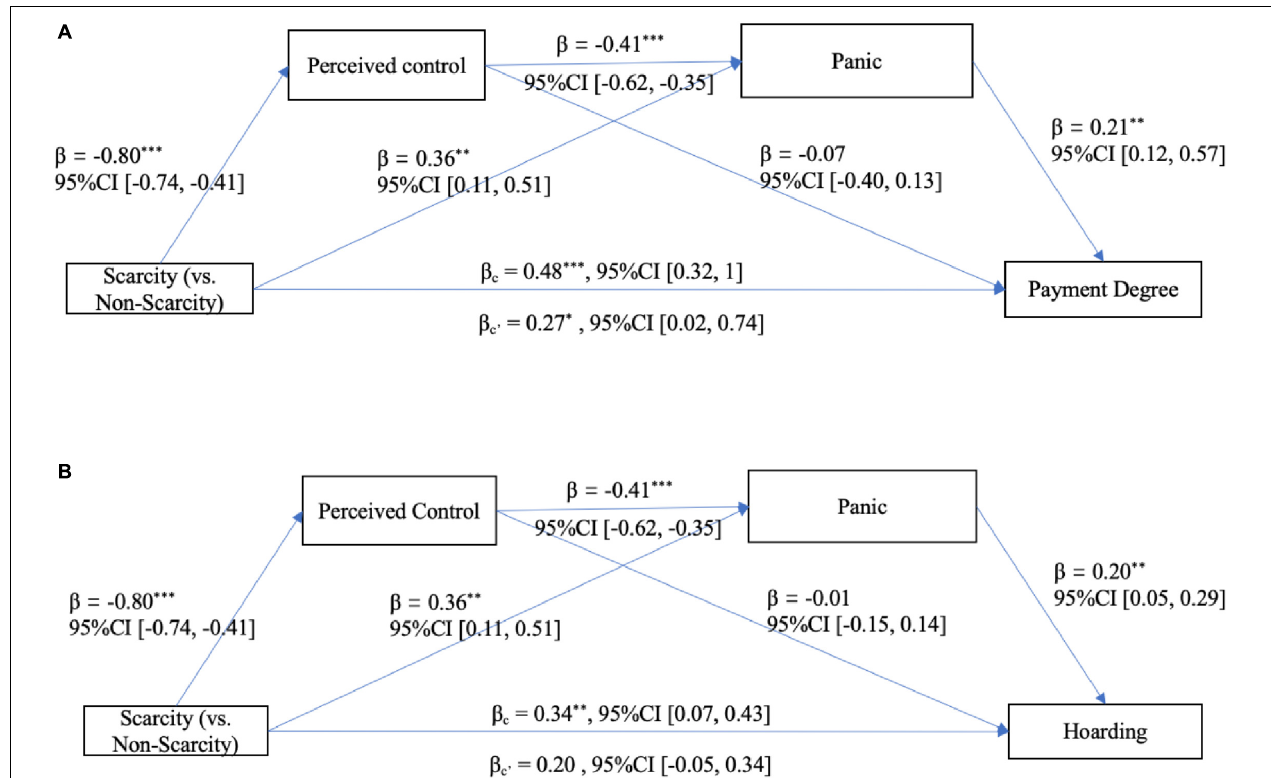
FIGURE 5 | (A, B) The serial mediation model of Study 3b. *** p < 0.001, ** p < 0.01, * p <